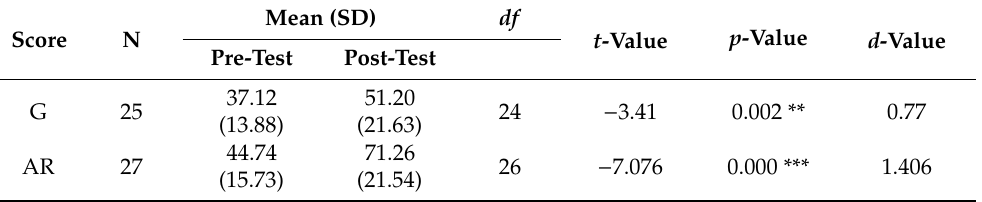
Table 5. Learning e ff ectiveness of test subjects from playing a general board game and AR-based board game.